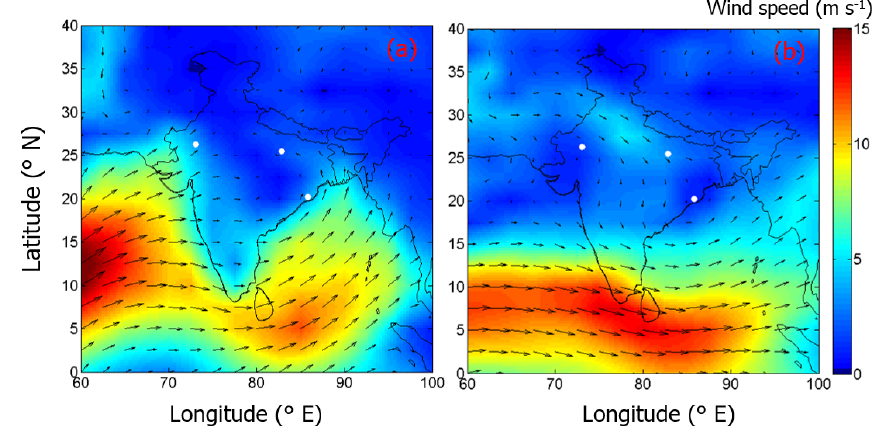
Figure 1. The strength and direction of winds at (a) 975hPa and (b) 700hPa over the Indian subcontinent during June 2016. White dots indicate the base stations. Wind data are from the ERA-Interim reanalysis. Table 1. Details of the sorties, including the dates, instruments used and rain events for the campaign period. Region Coordinates Height, m Period Remarks Instruments (base station) ( ◦ N, ◦ E) (a.m.s.l.) (2016) 20.24, 85.81 42 1–5 June Rain on 3 and 4 June after the